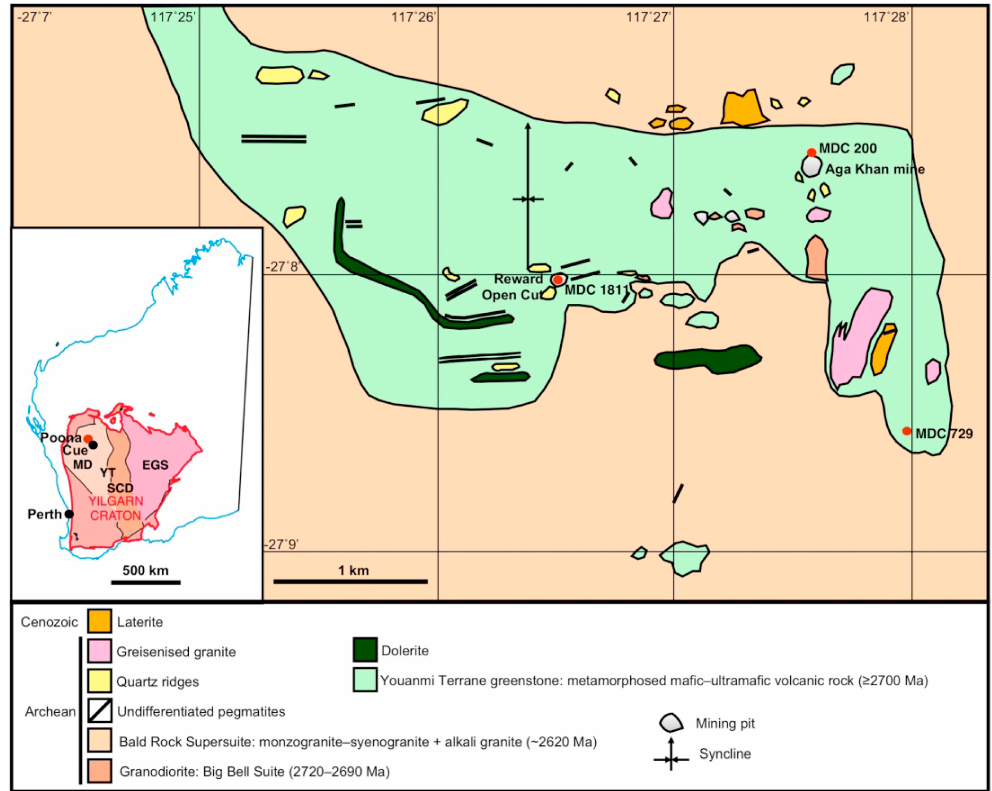
Figure 1. Index map (inset) and interpreted geological map of the Poona mineral field, Yilgarn Craton, Western Australia showing specimen localities (modified after [4,12], YT—Youanmi Terrane, MD—Murchison Domain, SCD—Southern Cross Domain, EGS—Eastern Goldfields Superterrane).